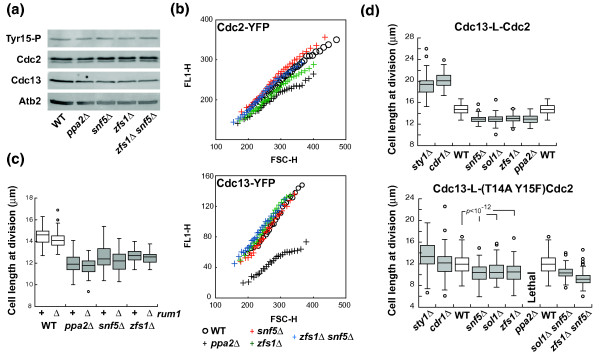
Premature cell division of snf5Δ, sol1Δ and zfs1Δ does not result from alteration of CDK protein levels, Rum1 activity or CDK Tyr15 phosphorylation. (a) Western blot of total cell lysates for phosphorylated-Tyr15 Cdc2, Cdc2, Cdc13 and α-tubulin (Atb2) protein levels in different small size mutants. (b) Cdc2-YFP (upper panel) or Cdc13-YFP (bottom panel) fluorescent signal in different small size mutants. Fluorescence signal of >7,000 cells was measured by flow cytometry and plotted as a moving average (window 250 cells) against forward scattered light. Note the reduced Cdc13-YFP level in the ppa2Δ strain. (c) Cell length at division of small size mutants carrying rum1+ or rum1Δ gene deletion (n = 60 cells). (d) Size phenotype of gene deletions in a strain carrying the Cdc13-L-Cdc2 (upper panel) or Cdc13-L-(T14A Y15F)Cdc2 (bottom panel) fusion proteins. Upper panel, n = 60 cells; bottom panel, n = 150 cells. P-value was determined by Student's t-test. WT, wild type; YFP, yellow fluorescent protein.